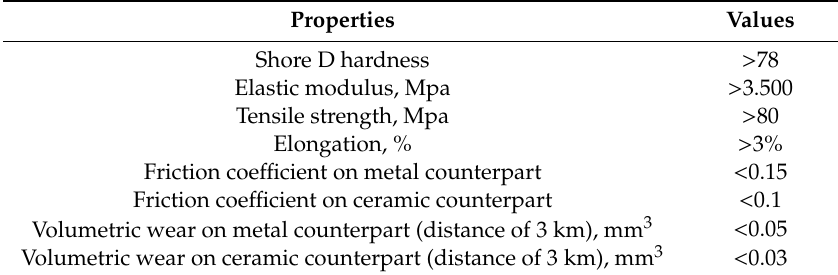
Figure 2. Diagram of the control parameters to ensure that the tribological properties meet the specified limits for the PEEK-based composites. Table 1. Specified operational properties for the PEEK-based